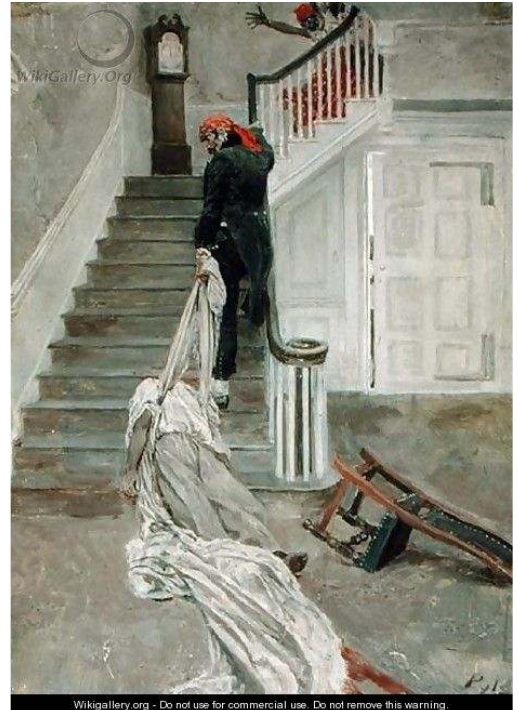
Figure 15. Howard Pyle, The gigantic monster dragged and hacked the headless corpse of his victim up the